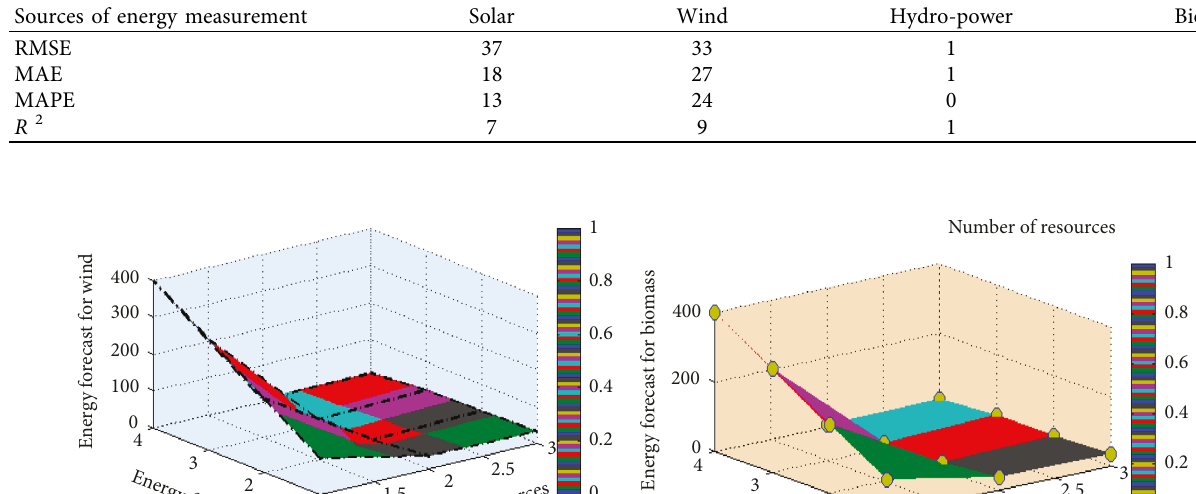
Table 1: Measurements of forecasting